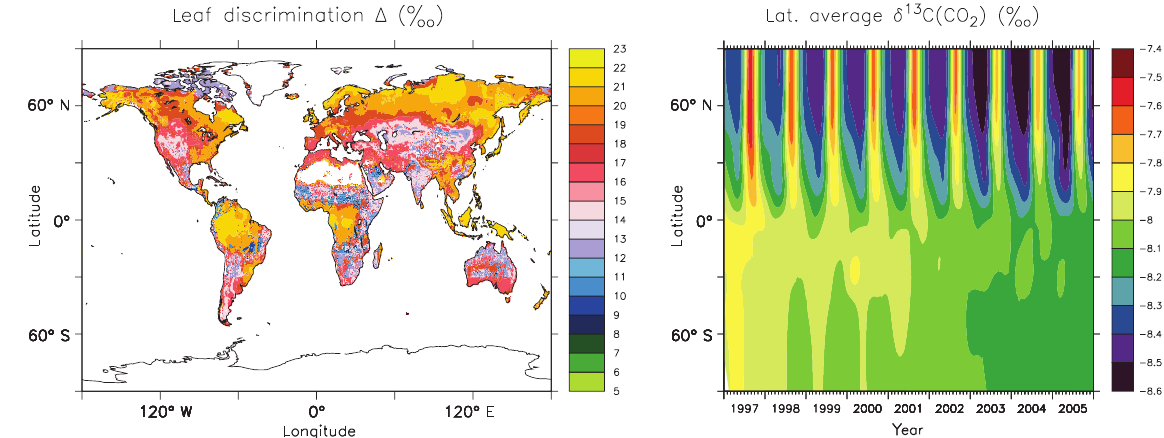
Figure 5. (a) Global mean leaf discrimination distribution (ISOLUCP experiment, Scholze et al., 2008). The distribution generally reflects the proportion of the C 3 / C 4 metabolism and characteristic carbon photorespiratory fractionation in the various ecosystems, land use regimes and climate zones. (b) Time series of the latitudinal average surface isotopic composition of CO 2 from the GLOBALVIEW-CO2C13 (2009)